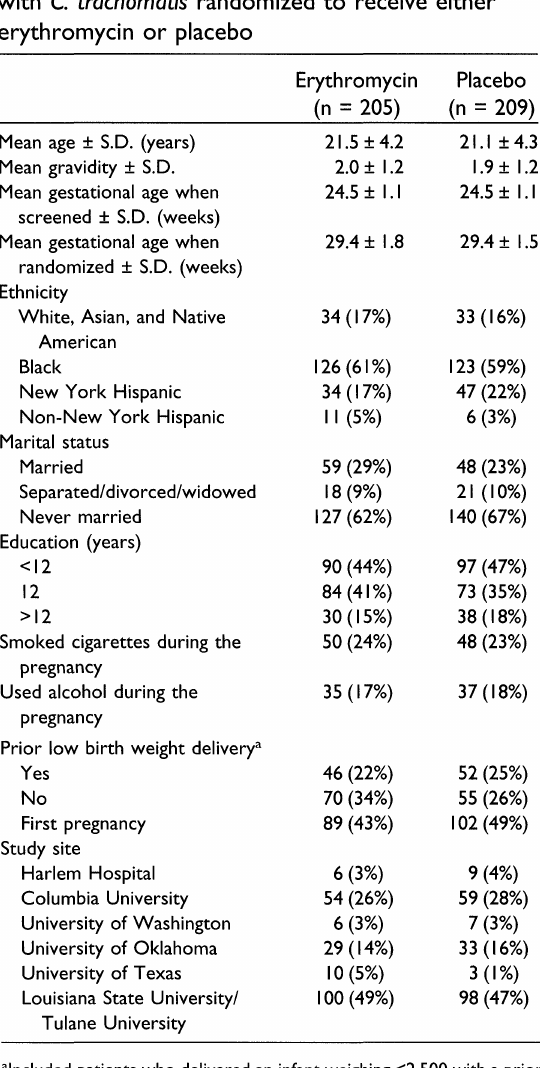
TABLE 2. Effect of erythromycin treatment on TABLE I. Descriptive characteristics of patients pregnancy outcome in patients with C. trachomatis with C. trachomatis randomized to receive either for the total group in an intent-to-treat erythromycin or placebo Erythromycin